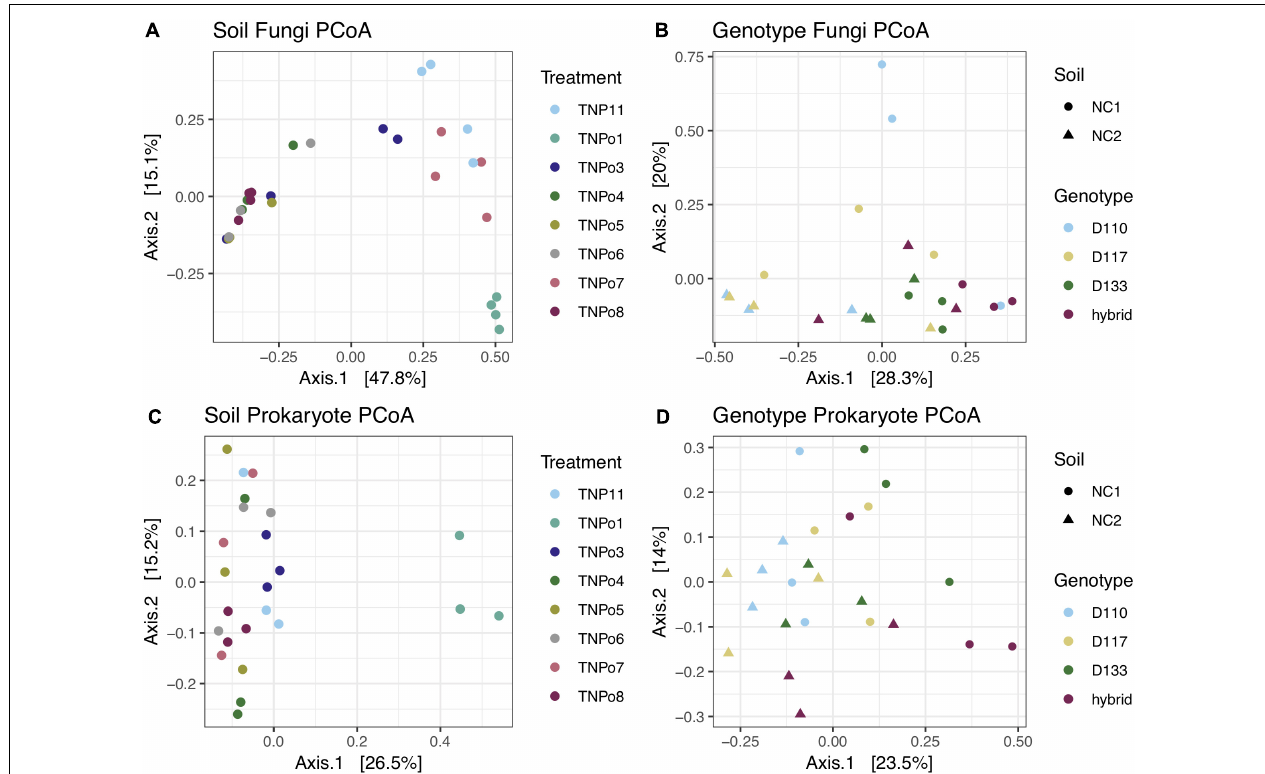
FIGURE 2 | Principle coordinates analysis (PCoA) showing beta-diversity of fungal and prokaryotic communities in the rhizosphere of Populus . (A) Fungal communities in different soils (Experiment 2); (B) Fungal communities in different Populus genotypes (Experiment 1); (C) Prokaryotic communities in different soils (Experiment 2); (D) Prokaryotic communities in different Populus genotypes (Experiment